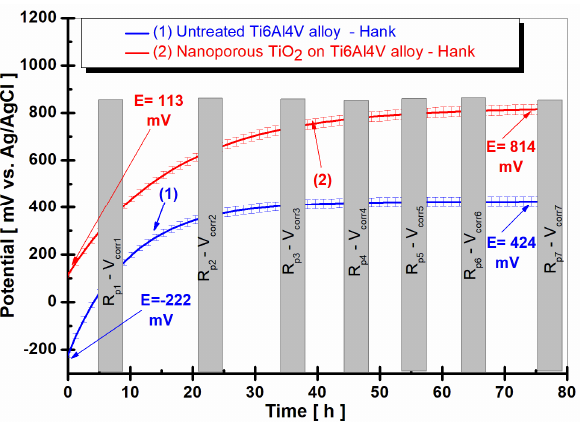
Figure 7. Comparative evolution of the open circuit potential during immersion in Hank’s biological solution for 80 h: (1) the untreated grade 5 Ti6Al4V alloy and (2) the treated grade 5 Ti6Al4V alloy with electrochemically formed titanium oxide surface film.